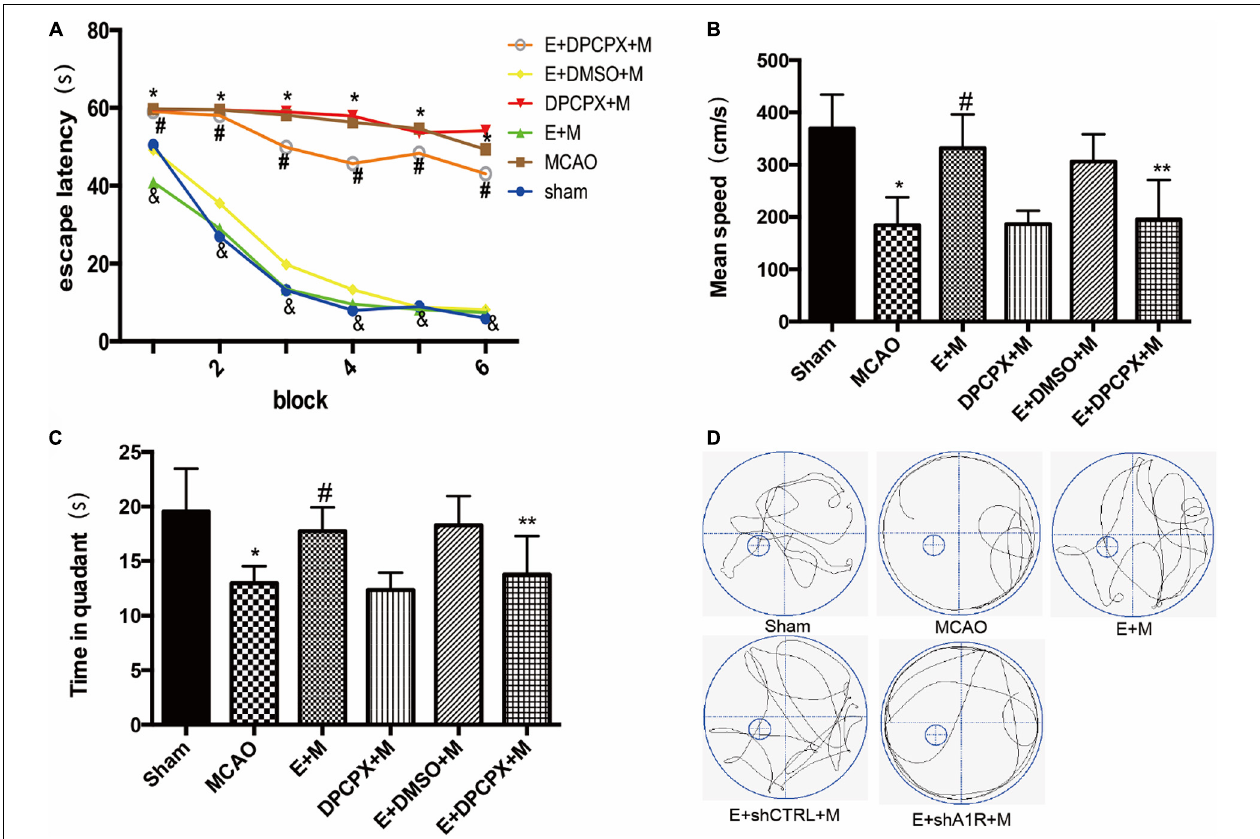
FIGURE 4 | Effects of DPCPX, an adenosine receptor 1 (A1R) antagonist, on cognitive function induced by electroacupuncture (EA) pretreatment ( n = 6). (A) EA pretreatment decreases the escape latencies in all trials; this is reversed by DPCPX; (B,C) effects of EA pretreatment with or without DPCPX on (B) mean speed and (C) time in quadrant. (D) The swimming tracks of rats in different conditions in the probe trial test. * P < 0.01 vs. the sham group, # P < 0.05 vs. the MCAO group, & P < 0.05 vs. the EA + MCAO group, ** P < 0.05 vs. the EA + MCAO